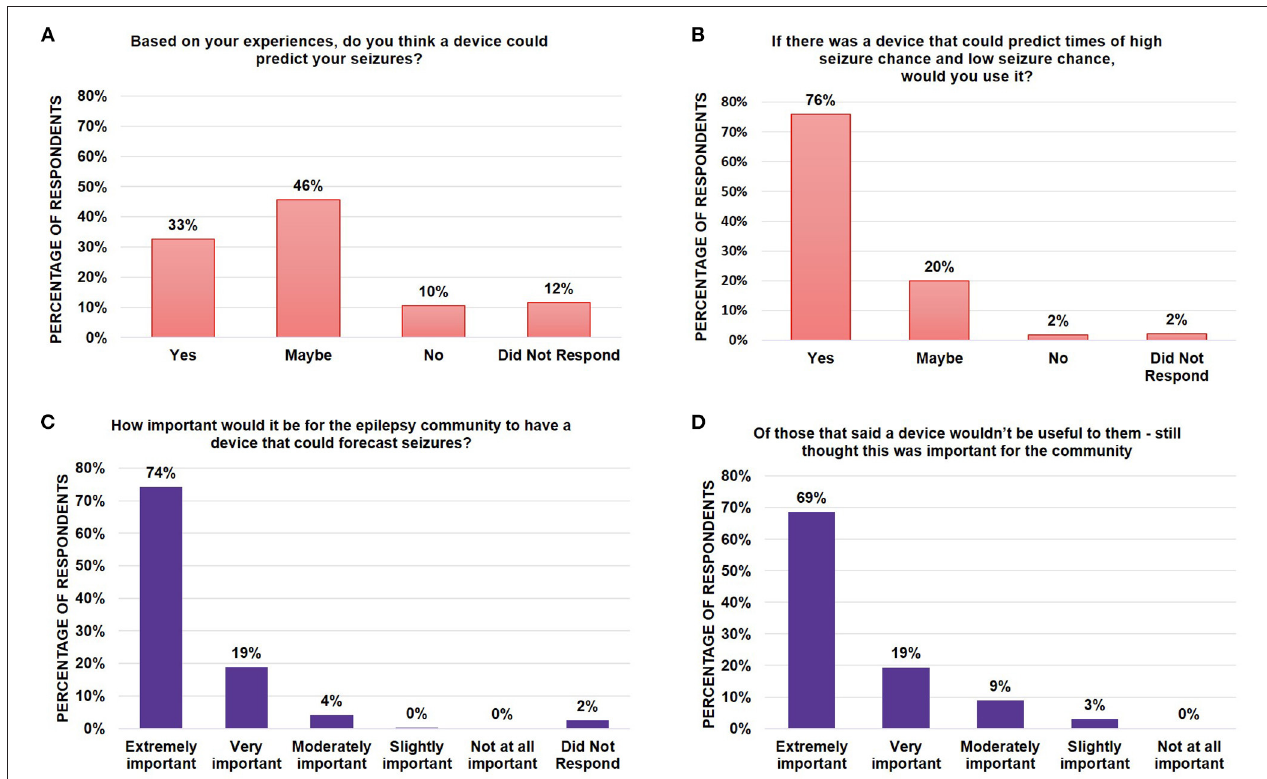
FIGURE 2 | Assessment of epilepsy community perspectives and need for forecasting tools. Bar graphs showing the percentage of survey respondents who indicated (A) whether they believed whether it was possible for a device to predict their chance of seizures; (B) whether they would use such a device if it existed; and (C) whether they believed it was important for the epilepsy community to have the device. Of those who did not believe that a device would be useful to them, (D) a bar graph indicated the breakdown of whether those respondents thought this was still an important device for the epilepsy community to have. Note that all numbers have been rounded to two significant figures. No significant differences were found between segments using the Mann-Whitney U